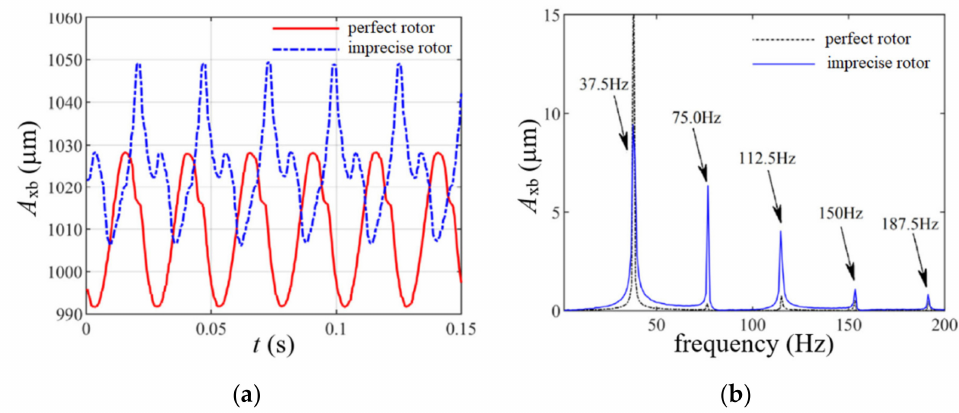
Figure 20. Amplitude in time domain and frequency spectrum for the both rod–disk rotor bearing system. ( a ) Amplitude in time domain; ( b ) Frequency spectrum.